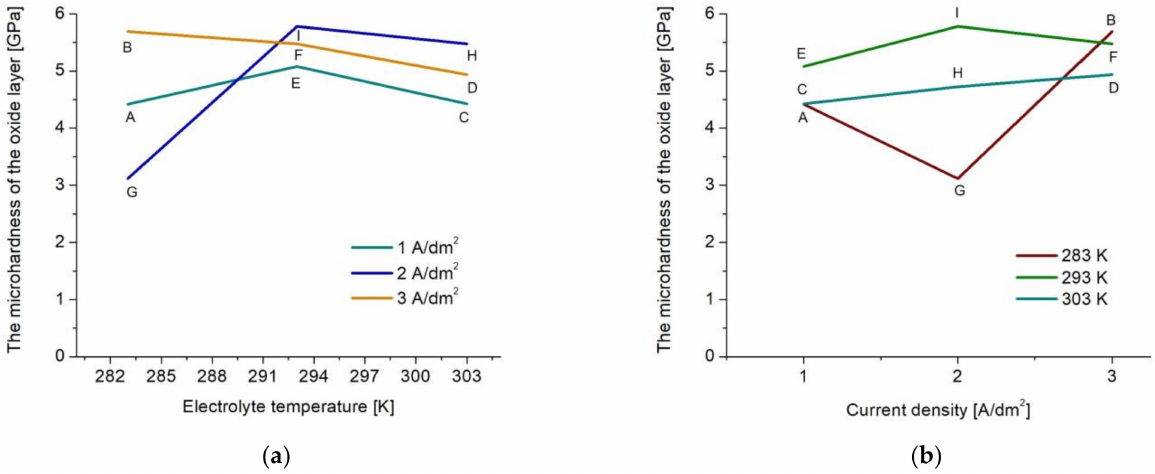
Figure 8. Dependence of the microhardness of oxide layers on changes in: ( a ) current density; ( b ) electrolyte